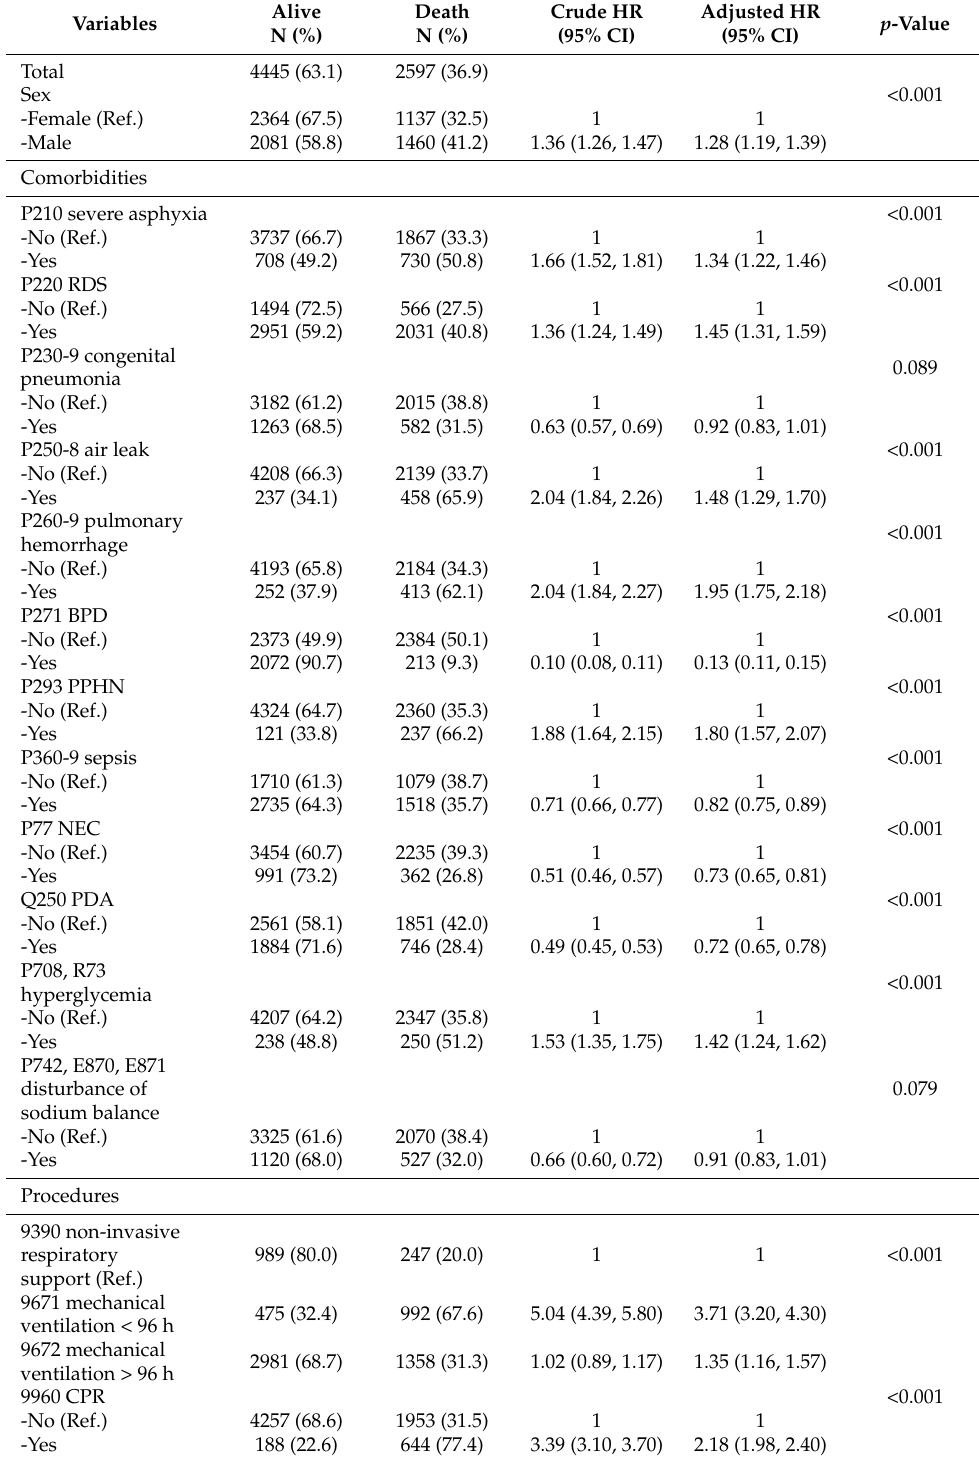
Table 3. Factors associated with mortality of ELBW infants by Cox proportional hazards regres- sion